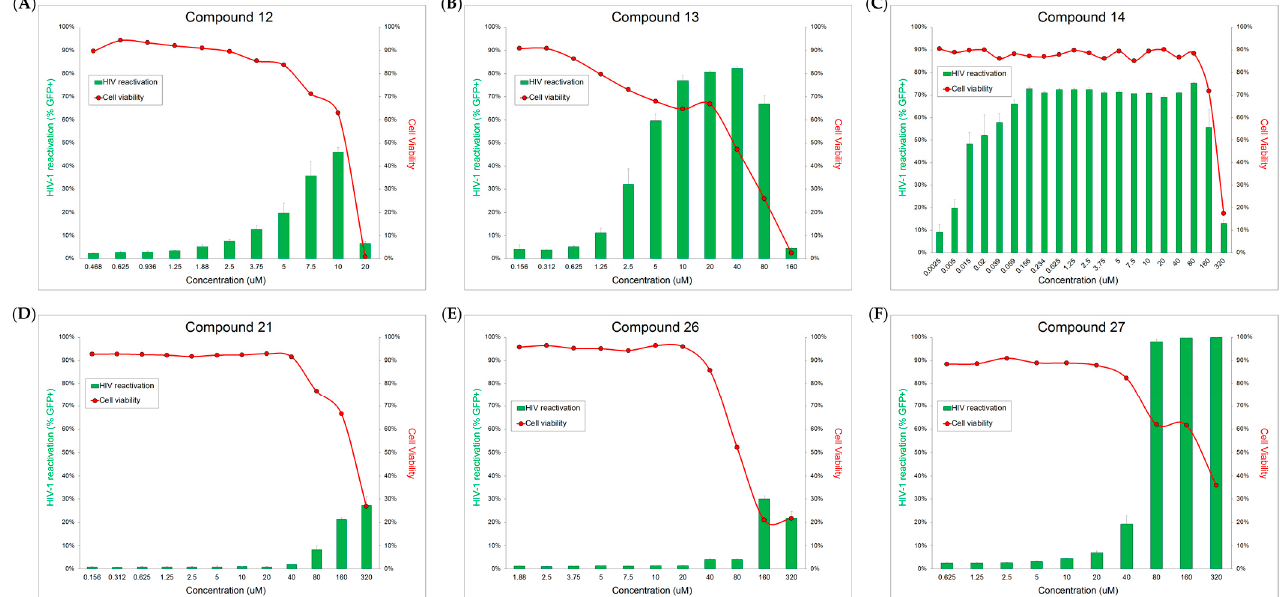
Figure 5. HIV-1 latency reversal activity dose-response (green bar) and cytotoxicity (red curve) of active compounds 12 – 14 , 21 , 26 , and 27 at additional concentrations. ( A ) dose-response experiments of 12 in a series concentration from 0.468 to 20 μ M; ( B ) dose-response experiments of 13 in a series concentration from 0.158 to 160 μ M; ( C ) dose-response experiments of 14 in a series concentration from 0.0025 to 320 μ M; ( D ) dose-response experiments of 21 in a series concentration from 0.156 to 320 μ M; ( E ) dose-response experiments of 26 in a series concentration from 1.88 to 320 μ M; ( F ) dose-response experiments of 27 in a series concentration from 0.625 to 320 μ M.